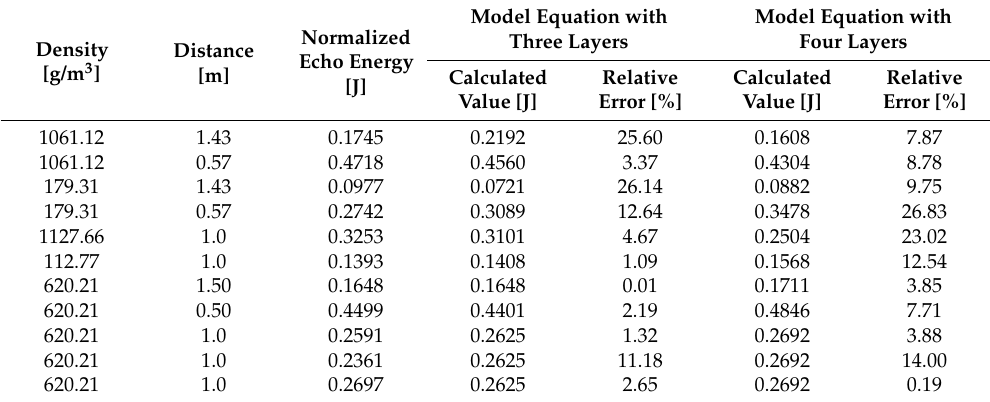
Table 8. Result of model equation contrast with 3 layers of leaves.